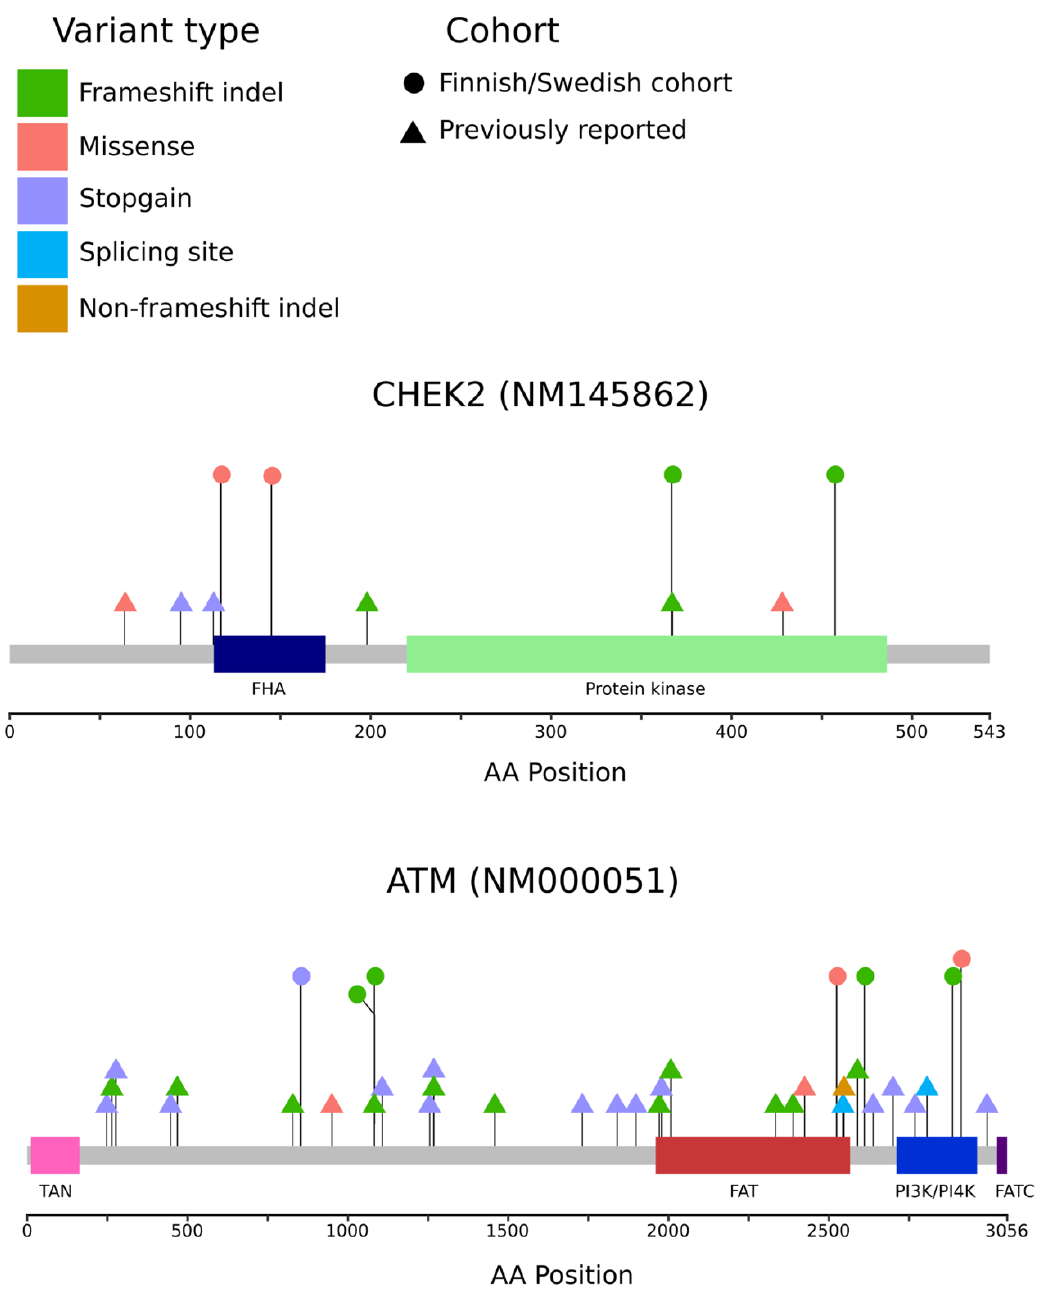
Figure 2. Potentially damaging variants found in the CHEK2 and ATM genes. Locations of variants shown as lollipop structures. The variants found in the Finnish/Swedish lethal or unselected cases are indicated by circles, and variants found in selected previous studies [7,11,18,28] are indicated by triangles. The variant type is indicated by the color.